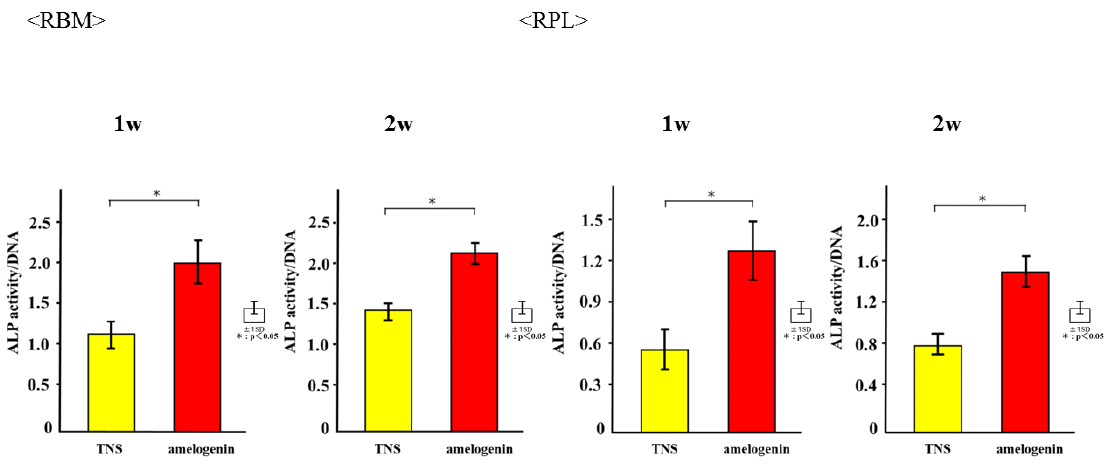
Figure 9. ALP activity in control and test groups. * p < 0.05.